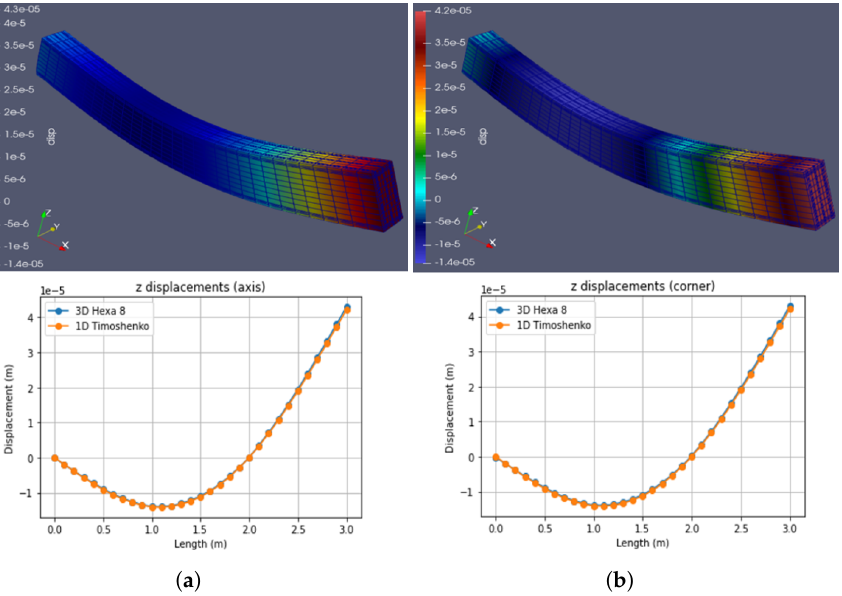
Figure 16. Case 3: at L = 1 m, Fz = − 1000 N. At L = 3 m, Fz = − 1000 N. ( a ) Hexa8. ( b ) Timoshenko. (Note: e − n indicates 10 − n